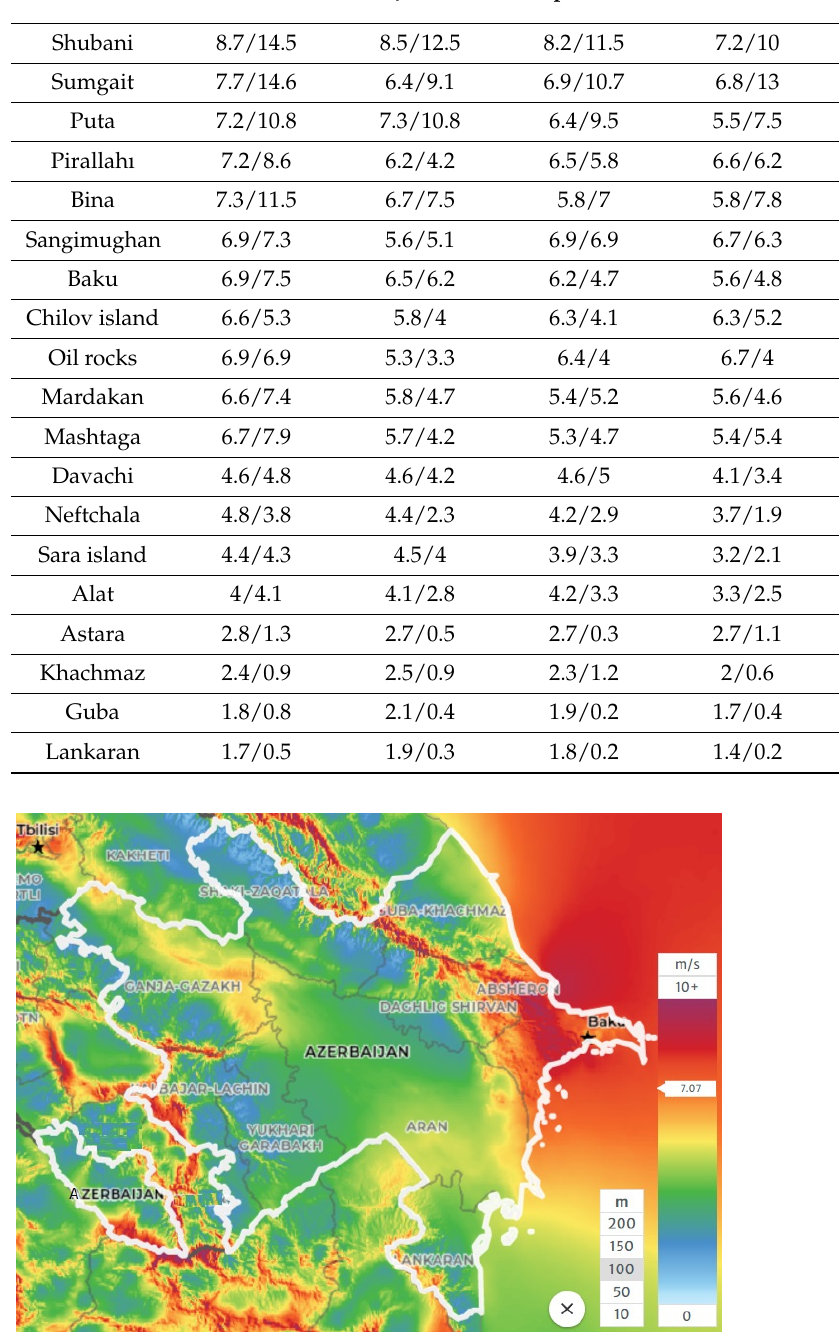
Figure 9. Wind power density at 100-m altitude [33]. The Ministry of Energy of Azerbaijan has presented five potential WEPs that could be set up with a total installed capacity of 442.5 MW (see Table 12). Table 12. Prospective WEPs projected by the Ministry of Energy of Azerbaijan [27,34]. Project Name